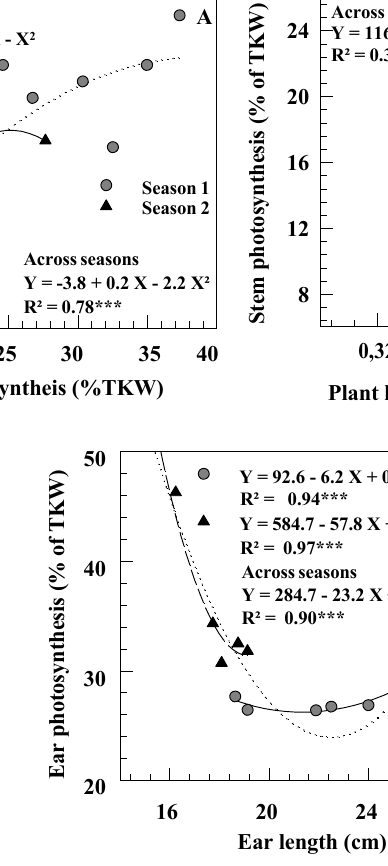
Figure 3. Relationships between photosynthesis (expressed in percent of thousand kernels weight) and ∆ G– ∆ C ( A ), morphological traits of ear ( B ) and of stem ( C ) measured on six durum wheat genotypes grown under rainfed conditions during two consecutive growth